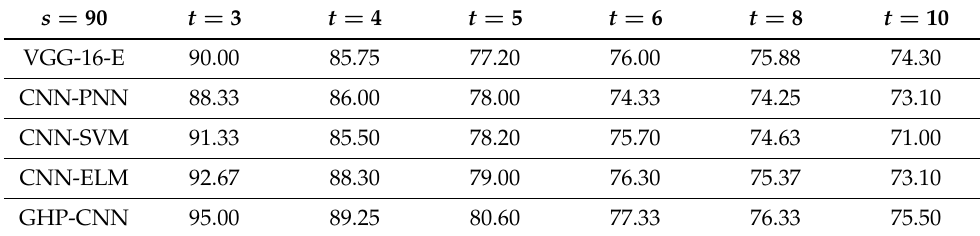
Table 4. Classification accuracy corresponding to different algorithms after the unknown categories with the CIFAR-100 dataset.